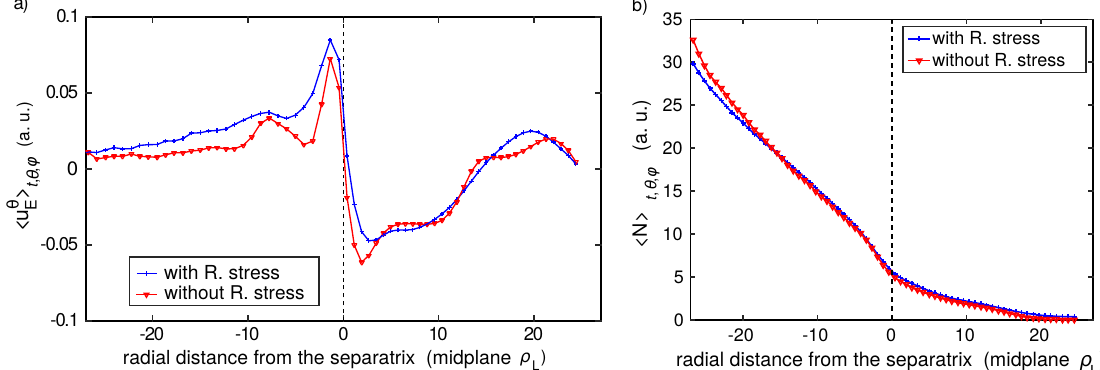
Figure 9. ( a ) Radial profile of the E × B poloidal velocity averaged on time ad over the flux surface in a COMPASS-like geometry, in the cases with and without Reynolds stress. ( b ) Comparison of the density averaged on the flux surface, in the two